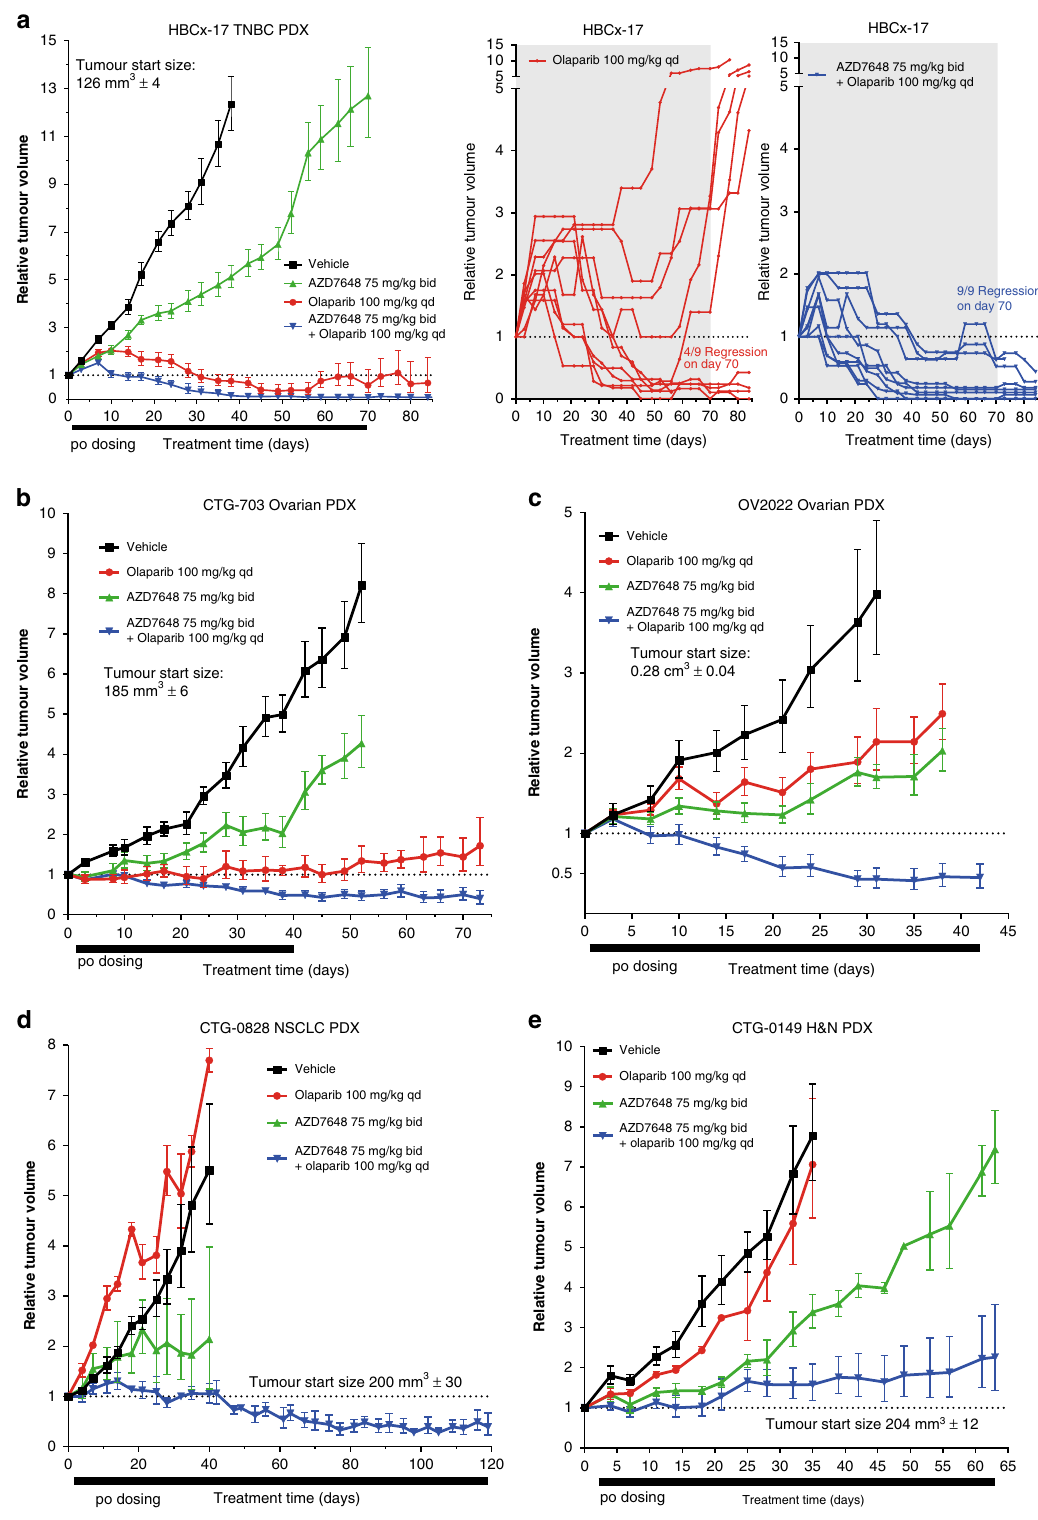
(Fig. 8). Four schedules were tested: 7ON 7OFF, 7ON 14OFF, 7ON 21OFF, and 14ON 14OFF. Of these four schedules, the 7ON 7OFF and 14ON 14OFF schedules achieved tumour regressions similar to those induced by the continuous com- bination schedule. The 7ON 14OFF and 7ON 21OFF schedules with longer holiday periods, while not achieving regressions,